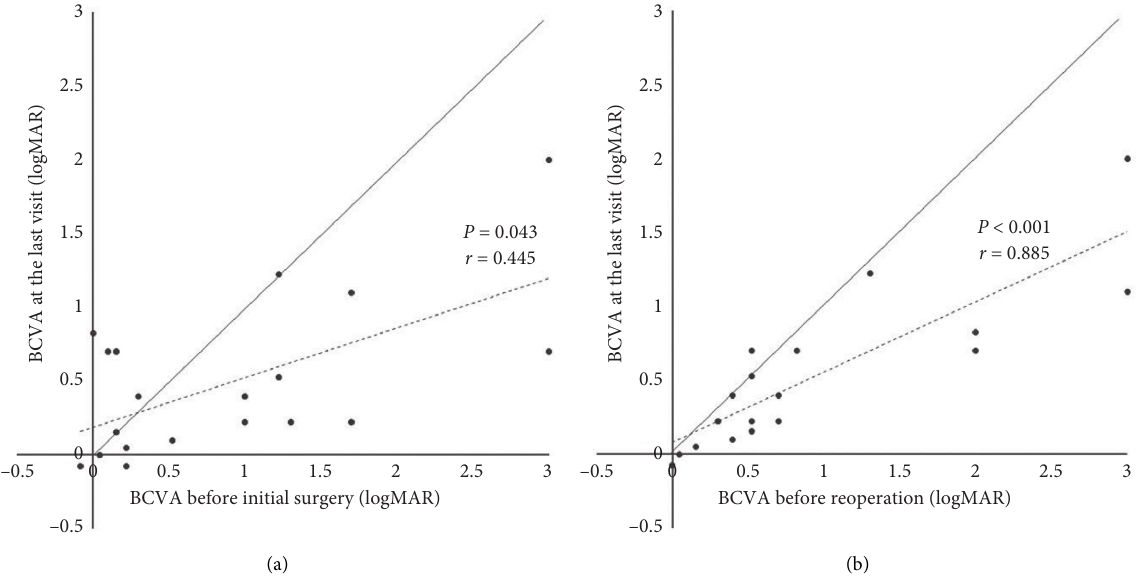
Figure 2: Visual acuity before the initial surgery, before the surgery for the recurrence, and at the last visit. (a) Best-corrected visual acuity (BCVA) before the initial surgeries and at the last visit. A better final BCVA was associated with the better BCVA before the initial surgeries ( r � 0.445, P � 0.043). (b) BCVA before the surgeries for the recurrent detachment and at the last visit. A better last BCVA was associated with the better BCVA before the surgery for the recurrent retinal detachment ( r � 0.885, P <